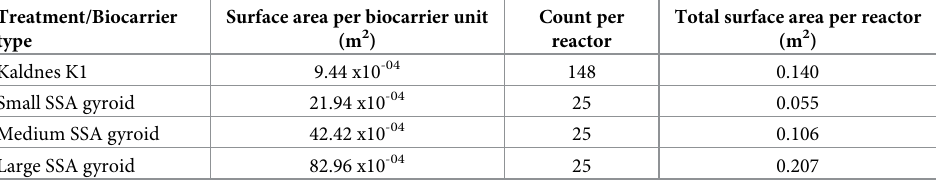
Table 2. Parameters for Experiment 1 with constant fill ratio (15%).